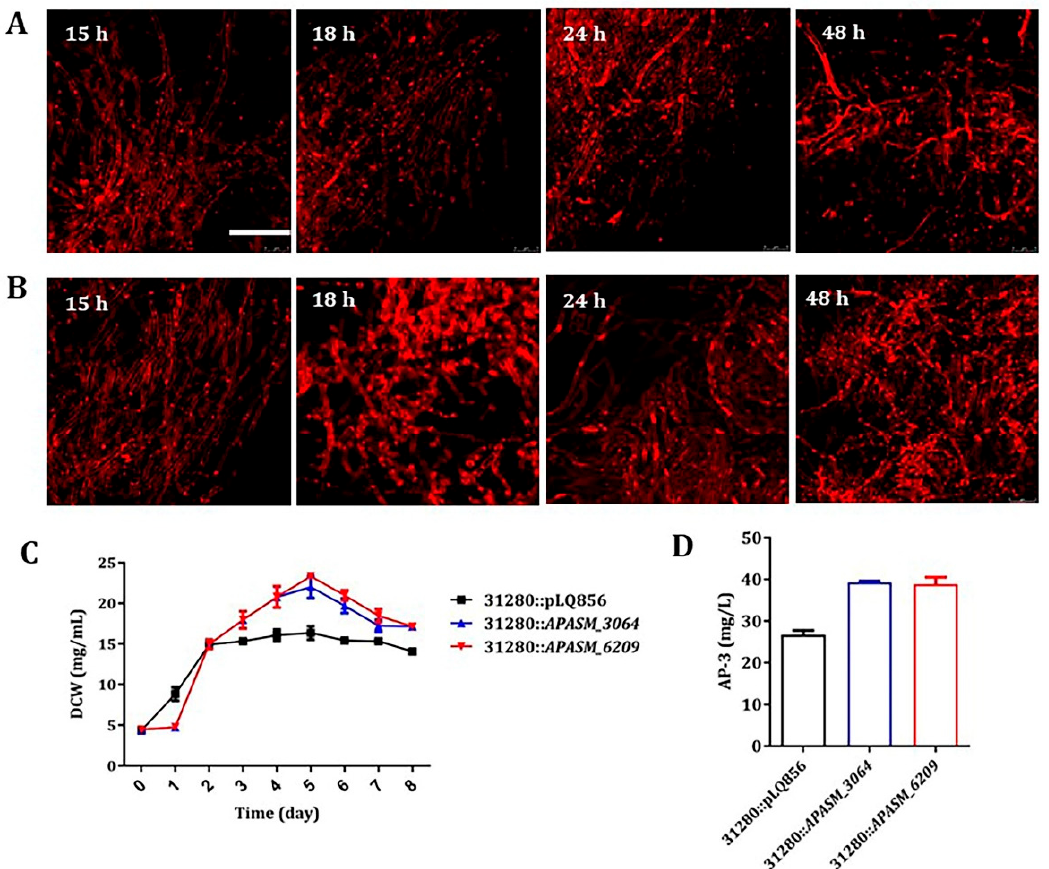
Figure 4. Overexpression of subtilisin inhibitor (SSI) genes in A. pretiosum ATCC 31280 alleviated mycelial fragmentation. ( A ) Confocal micrographs of mutant with SSI gene APASM_3064 overexpressed. Scale bar: 10 μ m. Magnification, 2,50×; ( B ) Confocal micrographs of mutant with SSI